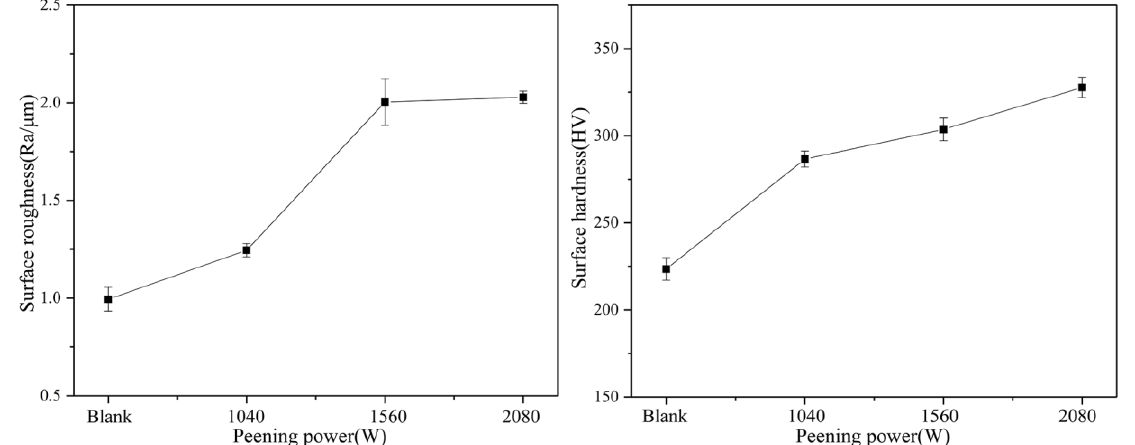
Figure 8. Surface roughness and microhardness evolutions of USPed samples with different levels of power.